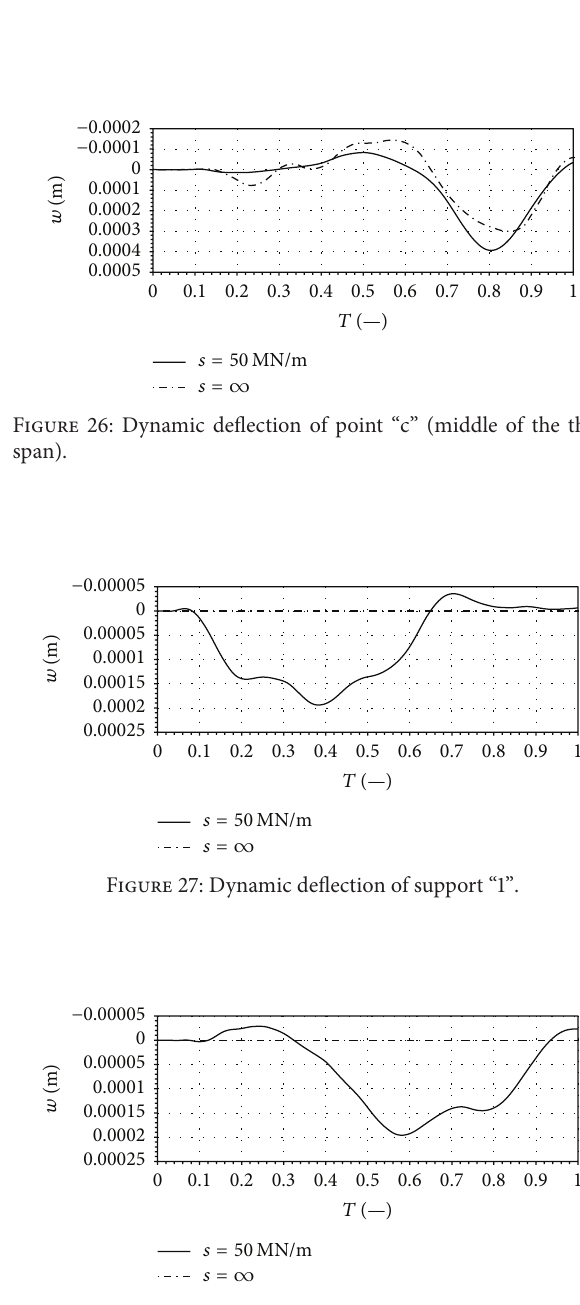
Figure 28: Dynamic deflection of support